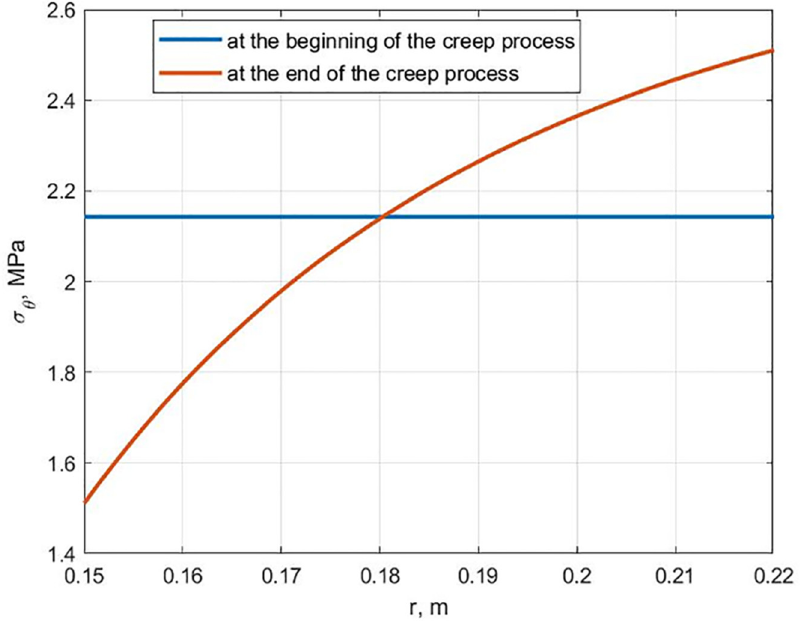
Figure 6. Dependancies of stresses σ θ along the radius at the beginning and at the end of the creep process for a cylinder equally stressed at the initial moment of